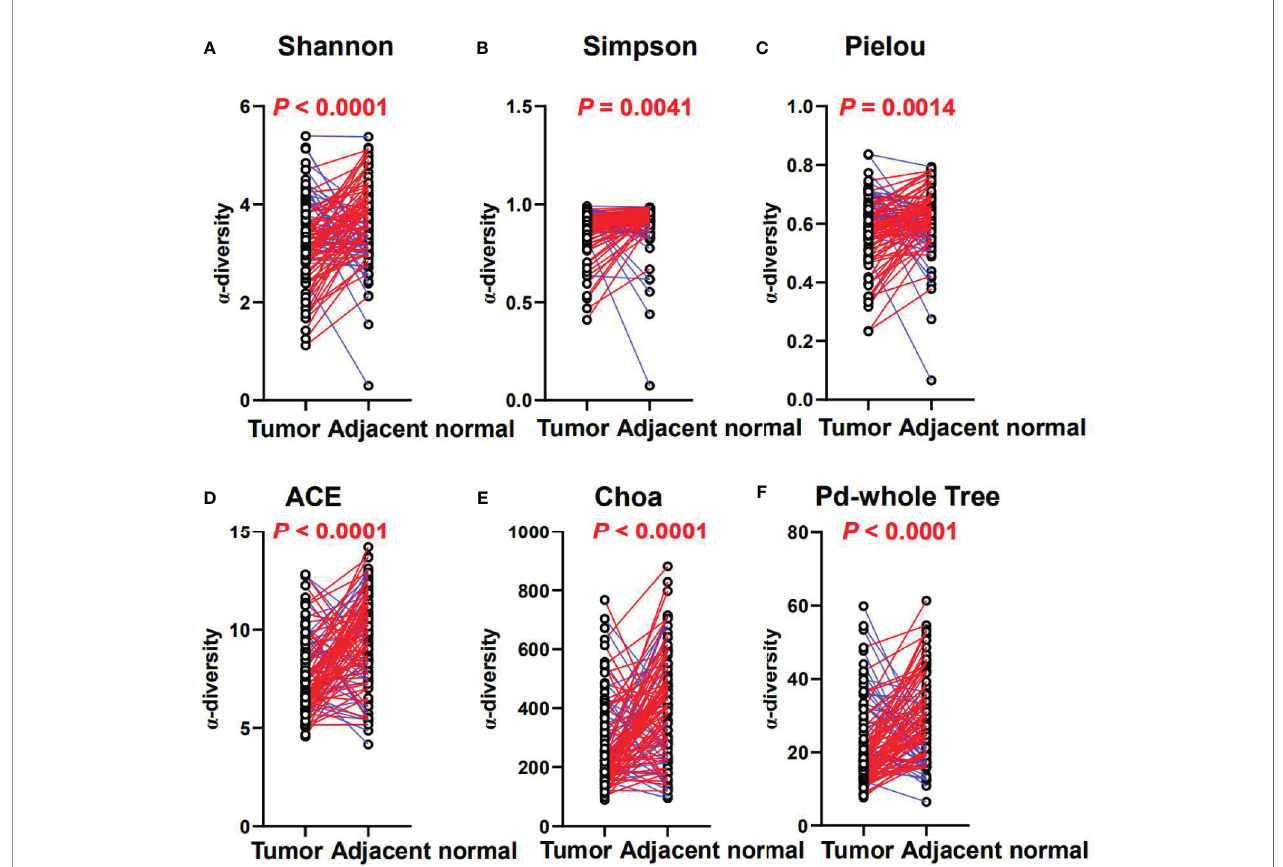
FIGURE 4 | The diversity and richness of the MAM in tumor and adjacent normal mucosae. The diversity indices, such as Shannon (A) , Simpson (B) , and Heip evenness (C) , and the richness indices, such as ACE (D) , Choa (E) , and PD whole tree (F) , are used to evaluate the overall structure of the mucosae microbiota in the CRC patients. p -values are derived from two-sided Wilcoxon signed rank tests. The colors indicate increase (blue) or reduction (red) of the diversity indices in tumor compared with adjacent normal